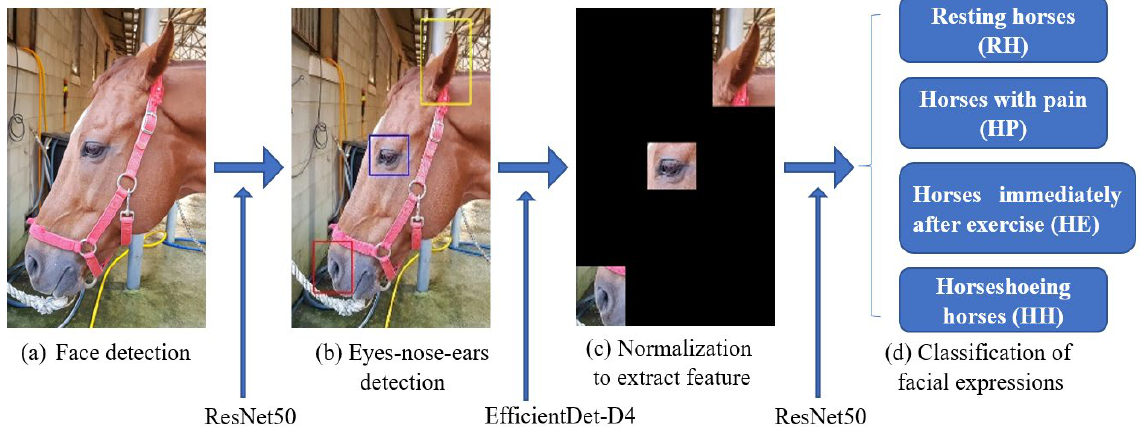
Figure 2. Pipeline of our automatic approach for the classification of various facial expressions of horses. ( a ) face detection, ( b ) eyes-nose-ears detection, ( c ) normalization to extract feature, ( d ) classification of facial expressions.